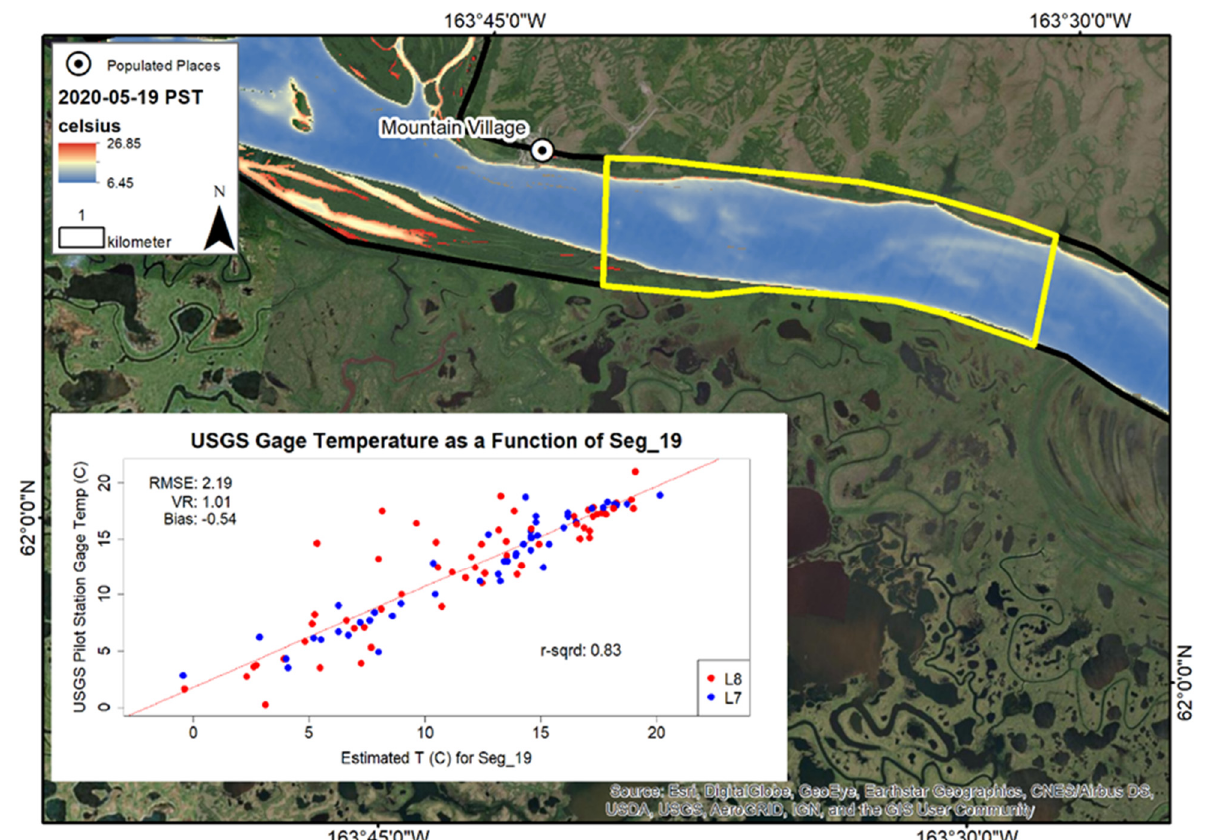
Figure A17. The Yukon River occupies a single channel roughly oriented east–west within Segment 19. Channel width is roughly consistent at a little over 2 km and bounded by the Andreafsky Mountains to the north and lowland flood plain to the south. The pST coverage is 100% with no NoData gaps. At high river stages, the channel is completely filled with water as depicted above. At lower stages, several sand and gravel bars are exposed in the mid-channel area. Correlation between water temperature datasets is good with RMSE = 2.19 °C and r 2 = 0.83.